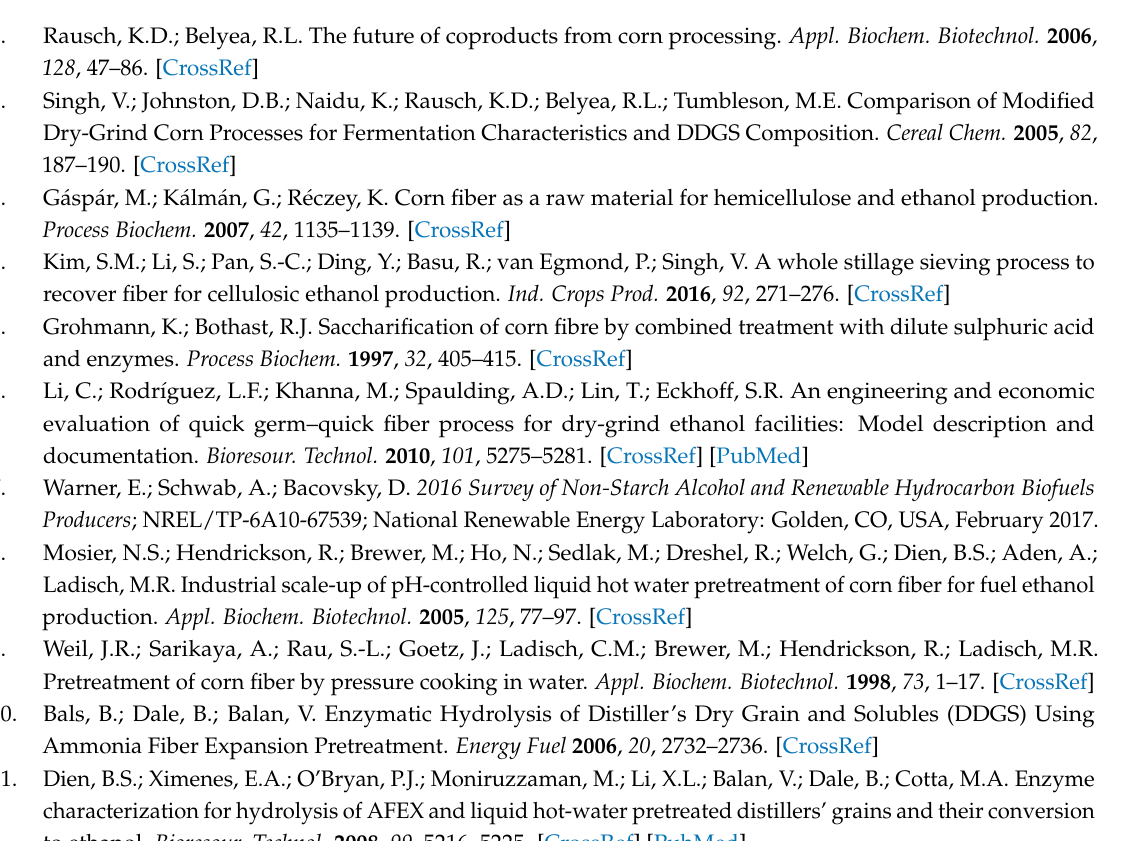
s1, Figure S1: Cellobiose profiles for fiber pretreated with hot water. Table S1: Ethanol concentrations achieved with different pretreatments after accounting for enzyme blanks. Table S2: Ethanol concentrations achieved with excess cellulase dose after accounting for enzyme